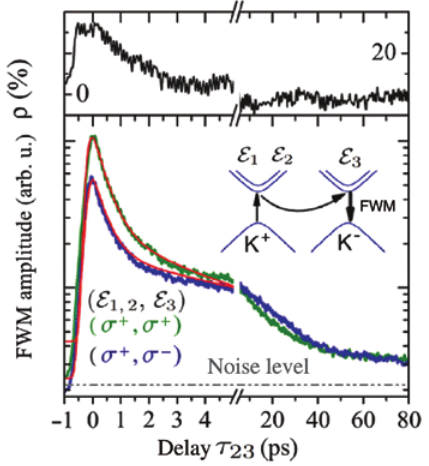
Figure 11: (Upper panel) Time-resolved polarization degree in an MoSe monolayer measured close to the A exciton resonance. 2 (Lower panel) Decay of the photoluminescence intensity in both cross- and co-circular polarization configurations in the same MoSe monolayer. Reprinted with permission from Ref. [14]. Copyright 2016 American Chemical Society.